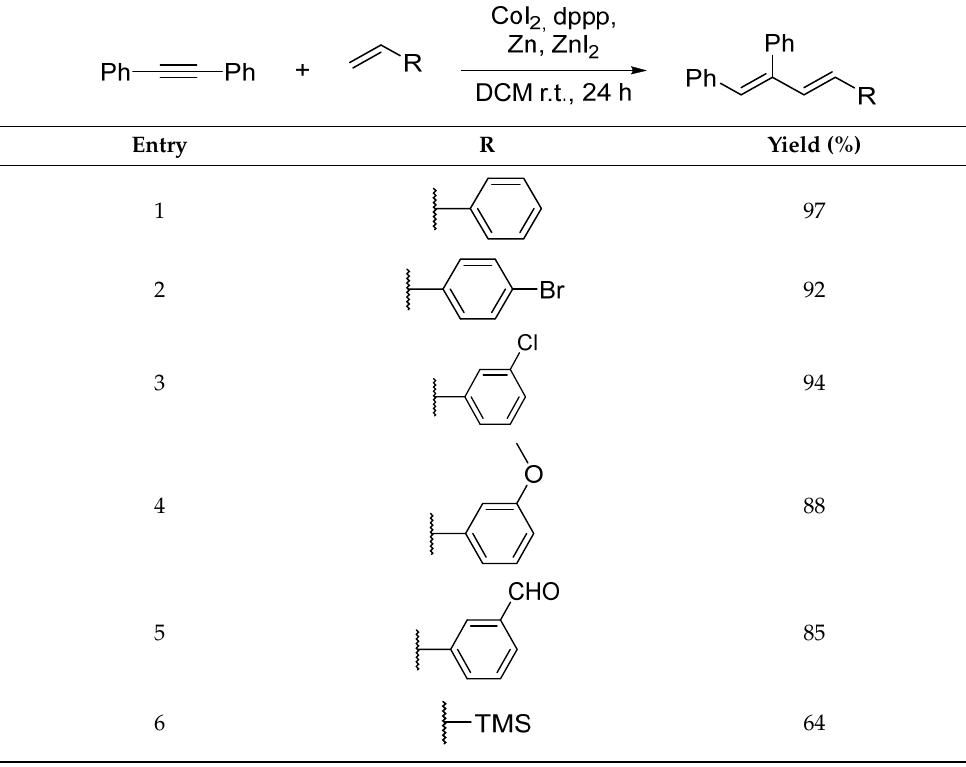
Table 7. Cheng et al.’s cobalt coupling.